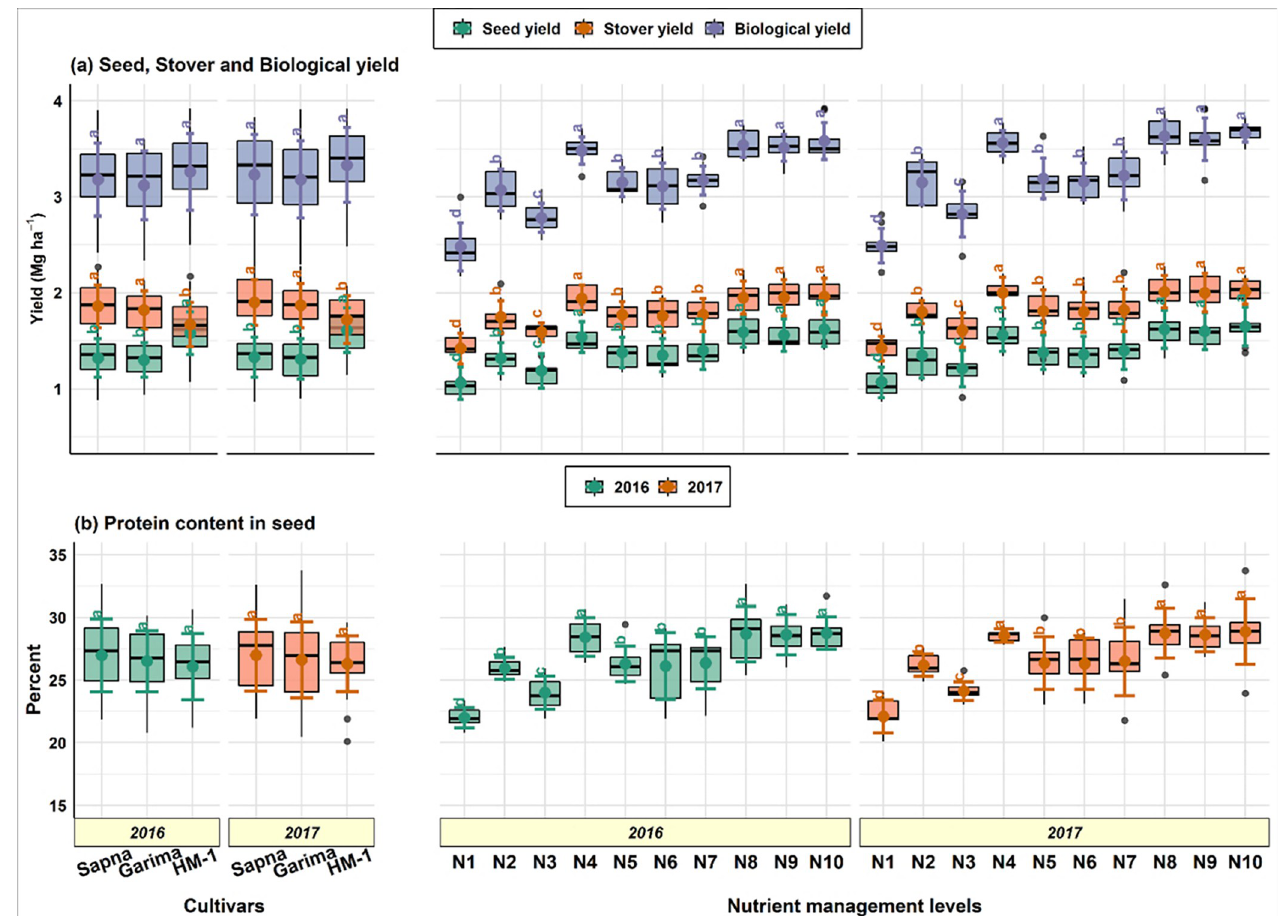
Fig 2. Crop yield (a) and seed protein content (b) of lentil cultivars under different nutrient management levels. � a–d Different letters in the same column indicate a significant difference at the 0.05 probability level, � NS–non-significant. N1: control; N2: 100% RDF; N3: VC at 2 t ha -1 ; N4: 50% RDN + 100% RDP + VC at 1 t ha -1 ; N5: RDF + 0.5% ZnSO 4 ; N6: RDF + 0.5% FeSO 4 ; N7: RDF + 0.5% ZnSO 4 + 0.5% FeSO 4 ; N8: 50% RDN + 100% RDP + VC at 1 t ha -1 + 0.5% ZnSO 4 ; N9: 50% RDN + 100% RDP + VC at 1 t ha -1 + 0.5% FeSO 4 ; and N10: 50% RDN + 100% RDP + VC at 1 t ha -1 + 0.5% ZnSO 4 + 0.5% FeSO 4 .